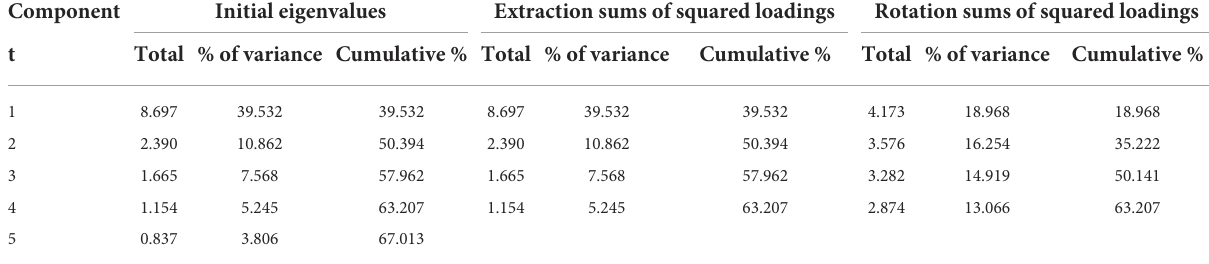
TABLE 2 Total variance explained. Component Initial eigenvalues Extraction sums of squared loadings Rotation sums of squared loadings t Cumulative